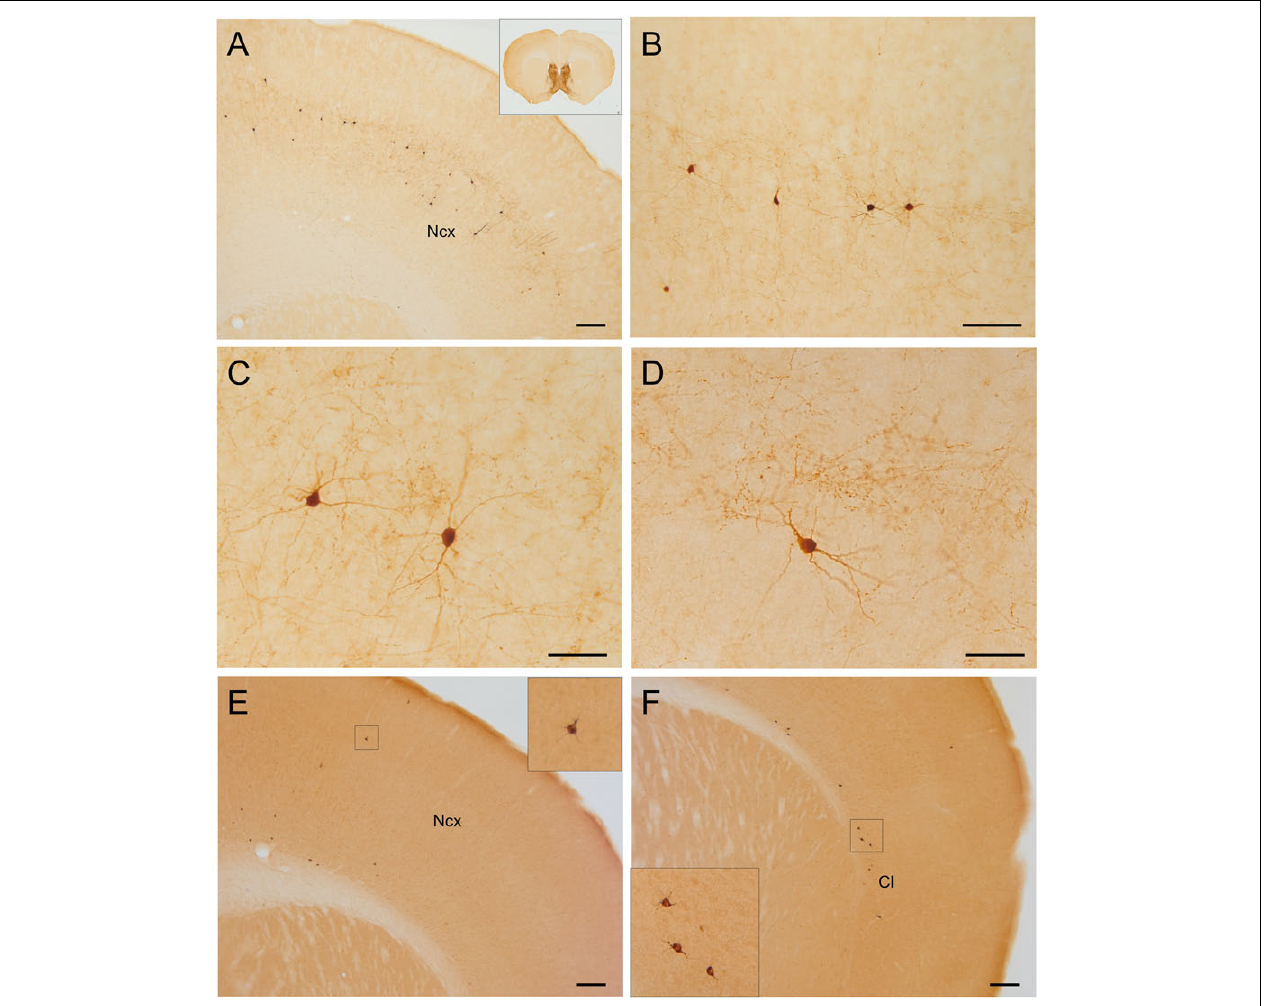
FIGURE 8 | GFP and HA immunoreactivity in the neocortex. Images of frontal brain sections of adult Otp-eGFP mice (A–D) and Otp-Cre; Rpl22-HA mice (E,F) , showing GFP or HA immunoreactive cells in the neocortex (A–F) and claustro-insular region (F) . Panels (B,C,D) display details of neocortical cells from the section shown in panel (A) . Scale bar: panels (A,E,F) = 200 µ m. Panel (B) = 100 µ m. Panels (C,D) = 50 µ